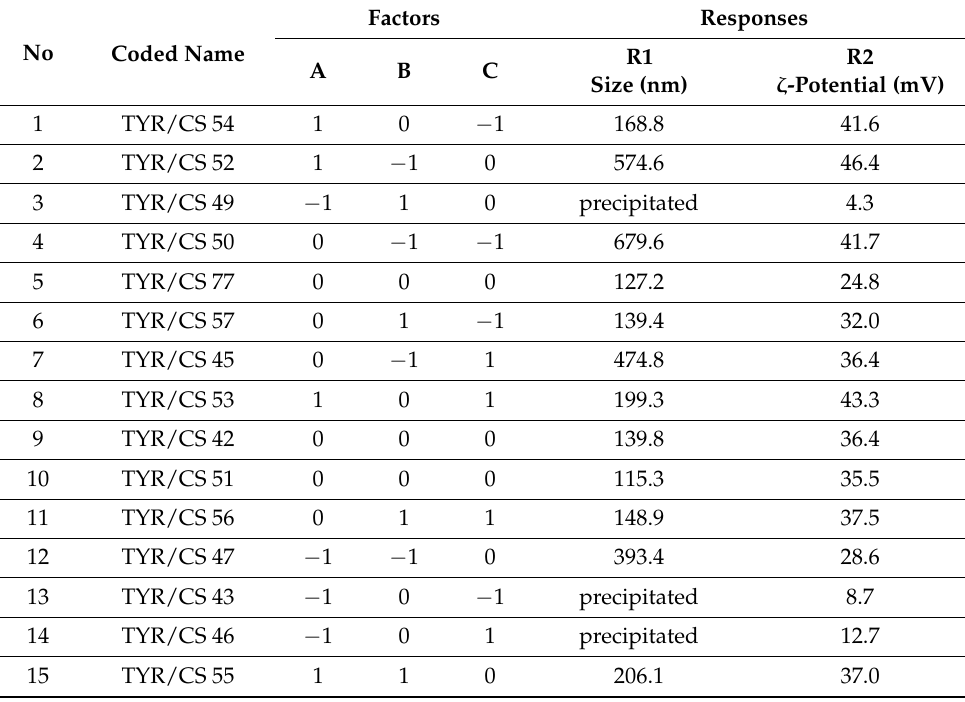
Table 2. Experimental data of TYR/CS nanosystem and obtained results.